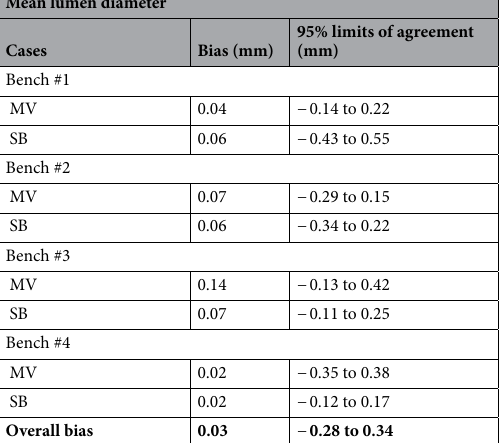
Table 4. Comparison of mean lumen diameter between computational stenting versus micro-computed tomography in bench cases by Bland–Altman analysis.